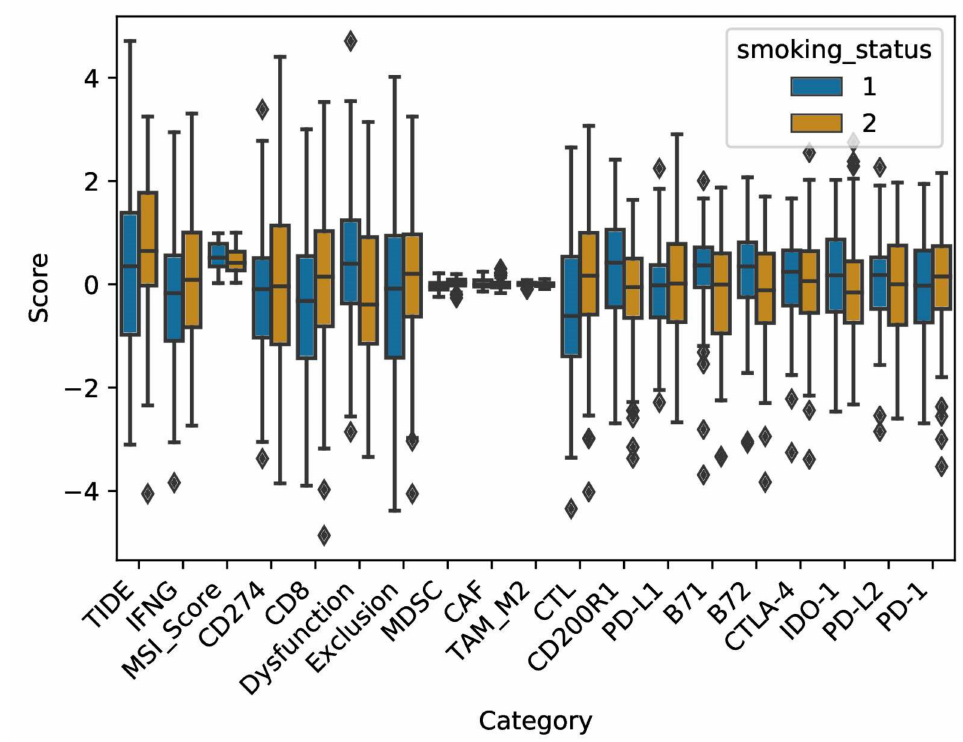
Figure 7. Functional state of infiltrating CTLs and Immune checkpoint genes expression. The functional state of infiltrating CTLs and their degree of exclusion from the tumor microenvironment were evaluated using TIDE. Furthermore, expression of eight immune checkpoint genes was analyzed in LADC patients with a history of smoking. (1) non-smokers; (2)